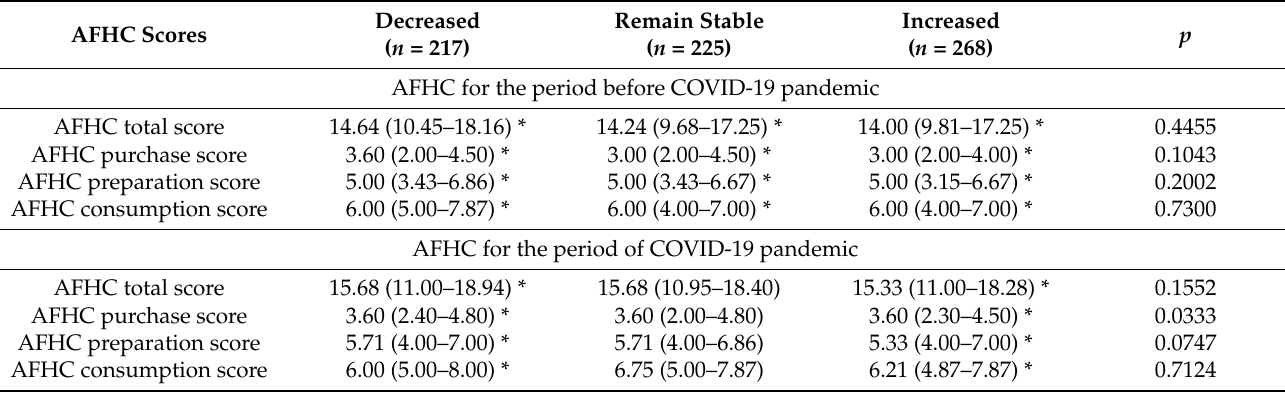
Table 4. The Adolescents’ Food Habits Checklist (AFHC) scores for the period before the COVID-19 pandemic and for the period of COVID-19 pandemic, stratified by physical activity changes during the COVID-19 pandemic, for the population of female adolescents from the Diet and Activity of Youth during COVID-19 (DAY-19) Study ( n = 710).